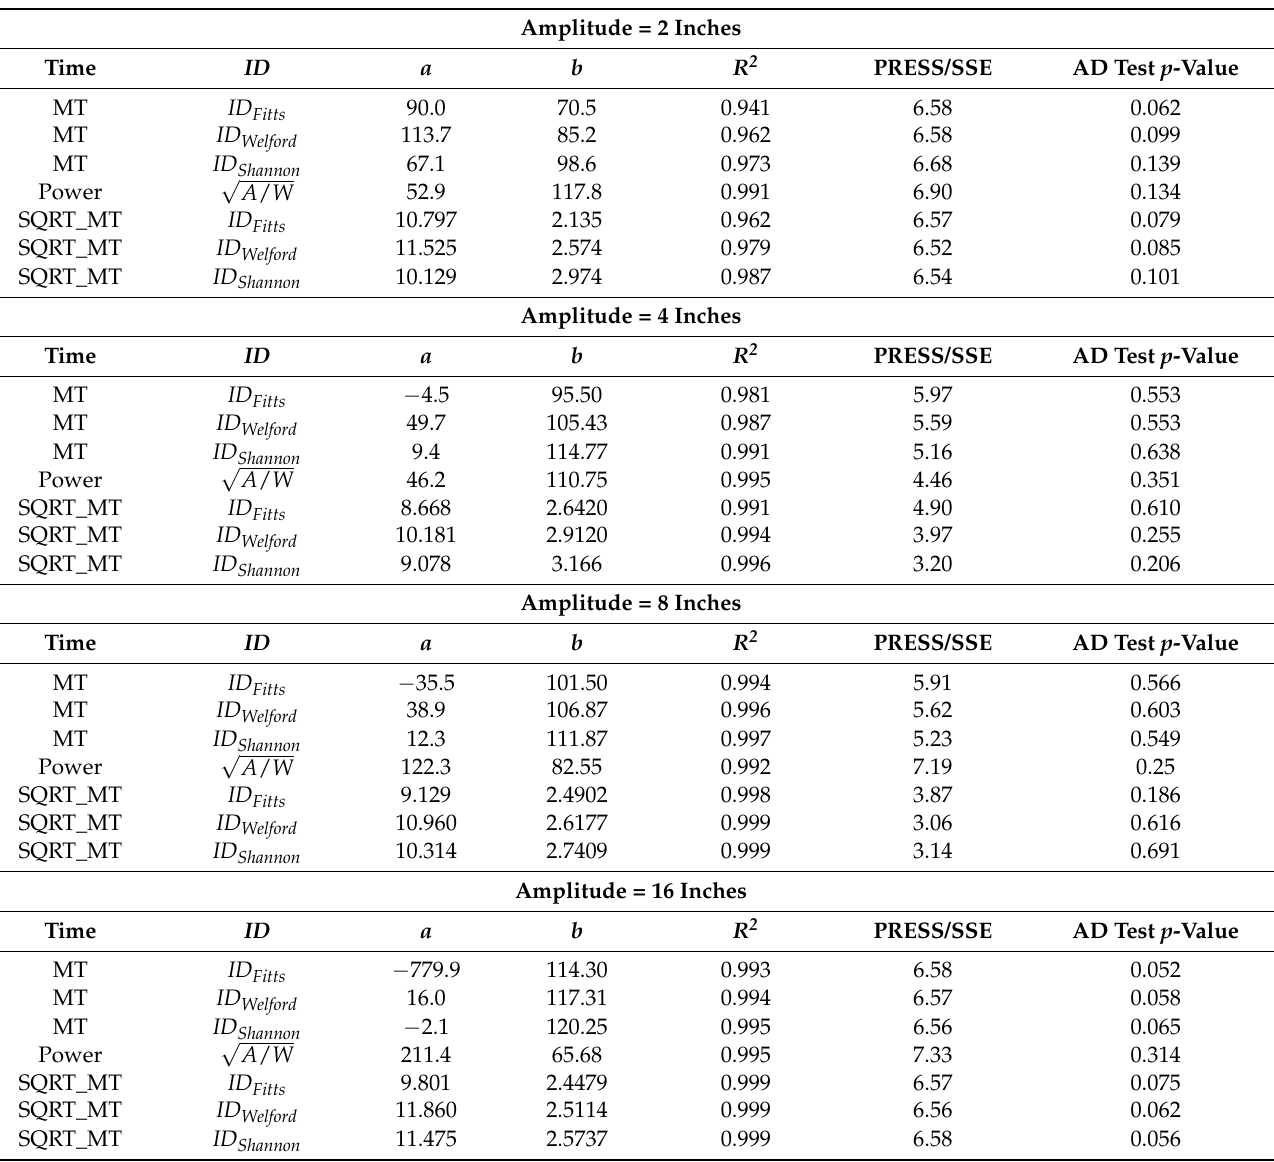
Table 3. Performances of 1 oz stylus tapping for the same amplitude with Fitts’ data [1]. The performances in all statistics but PRESS/SSE were